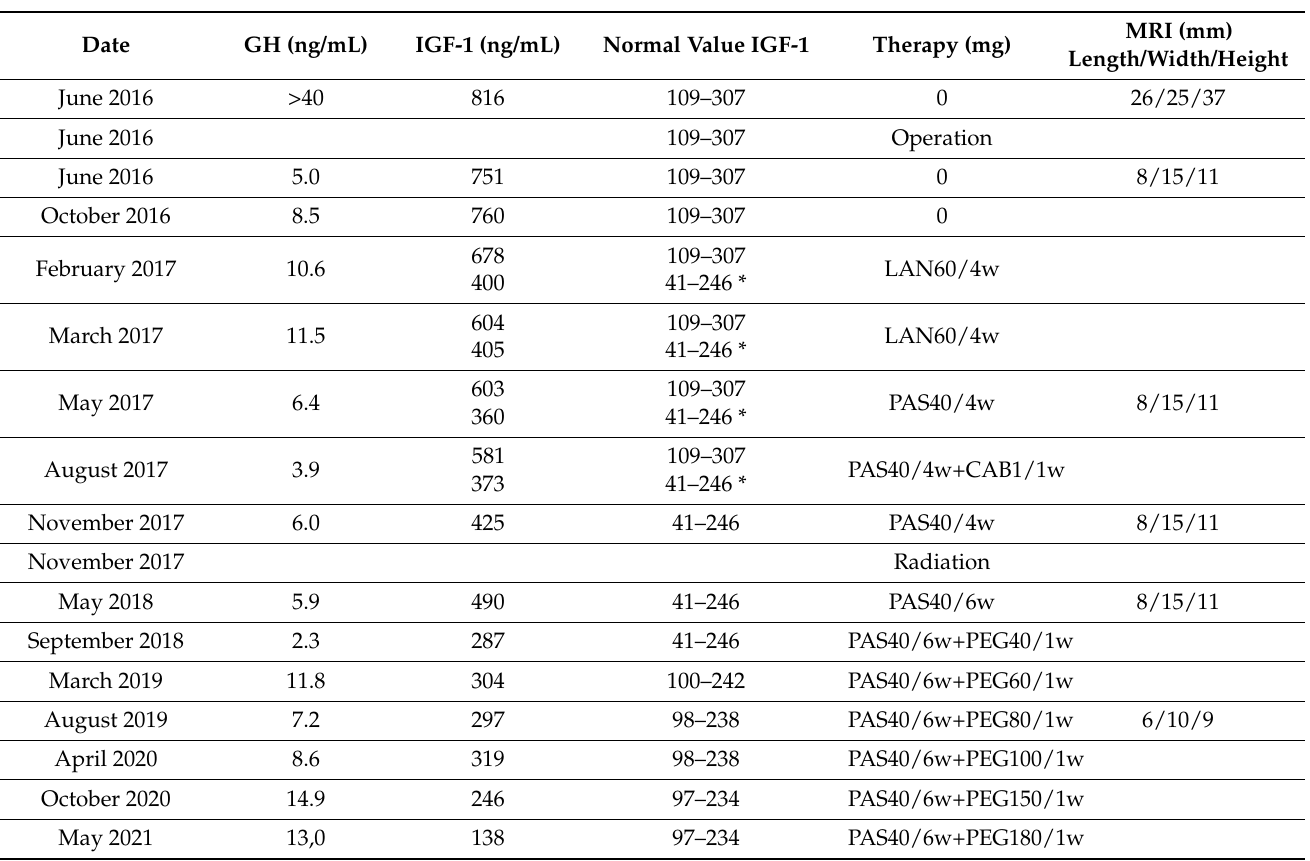
Table 2. Patient 2 laboratory data.